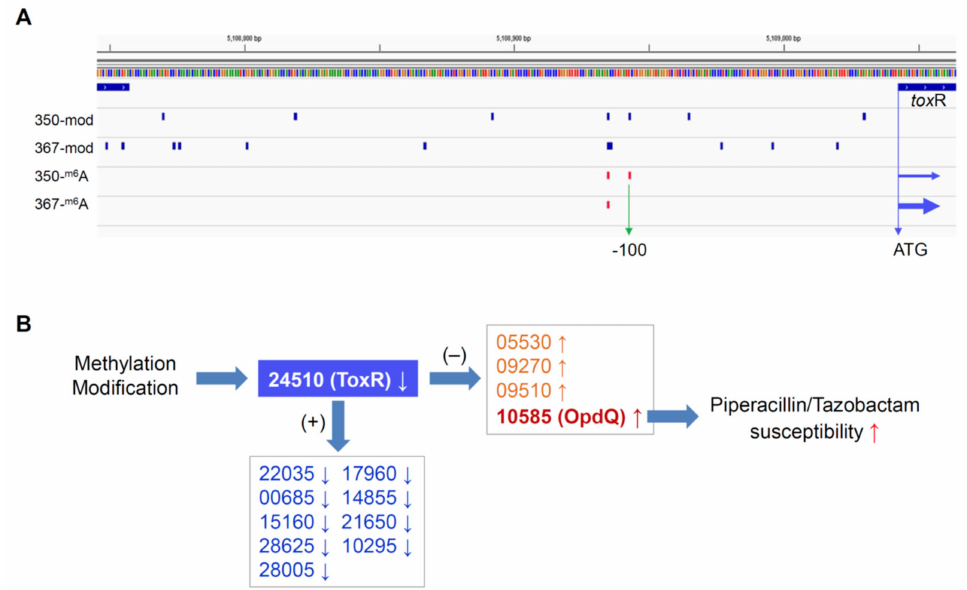
Figure 3. Hypothesized epigenetic regulation mechanism of P. aeruginosa antimicrobial resistance. ( A ) Methylation and modification in the promoter of ToxR in isolates PB367 and PB350, an extra m6A site was found in PB350 at − 100 (vertical green arrow) flanking from the translation start site (horizontal blue arrows) of ToxR, in addition to di ff erential modifications as compared with PB367; ( B ) Methylation and / or modification cause ToxR lower expression in PB350, which leads to higher expression of OpdQ and, furthermore, PB350 susceptible to Piperacillin / Tazobactam. + , positive transcription regulation; − , negative transcription